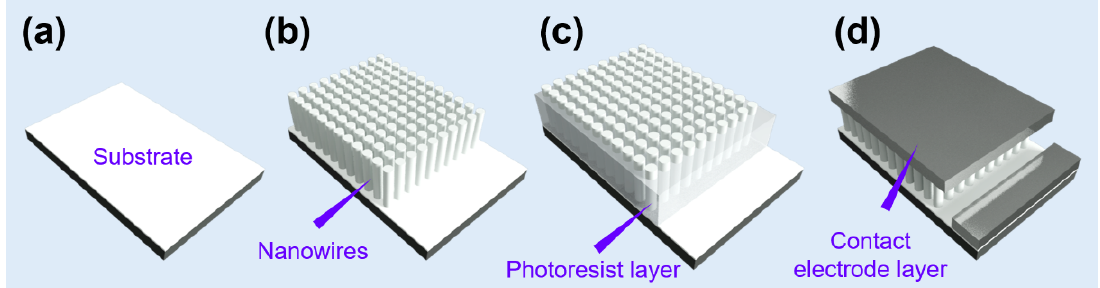
Figure 17. A typical method for making a vertical metal–oxide nanowires device: ( a ) the substrate with the seed/catalyst layer; ( b ) nanowires are grown vertically; ( c ) photoresist coating with the further etching process; and ( d ) top contact electrode deposition and the removal of photoresist.